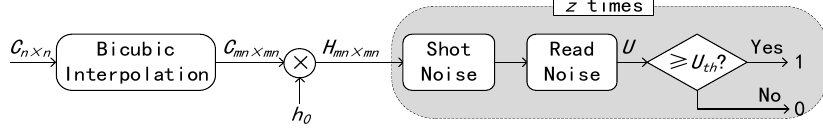
Figure 8. A block diagram of the single-bit QIS imaging model.